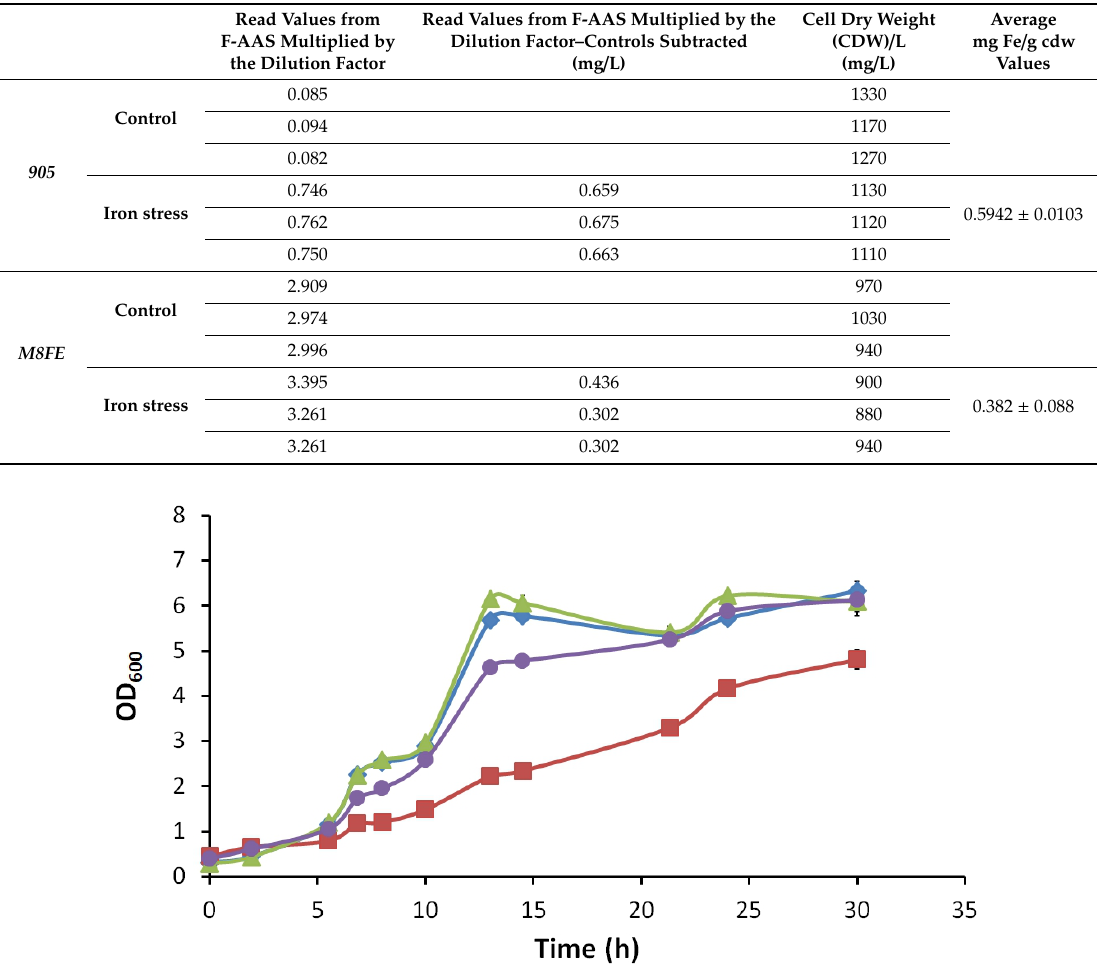
Table 1. Iron contents of M8FE and 905.